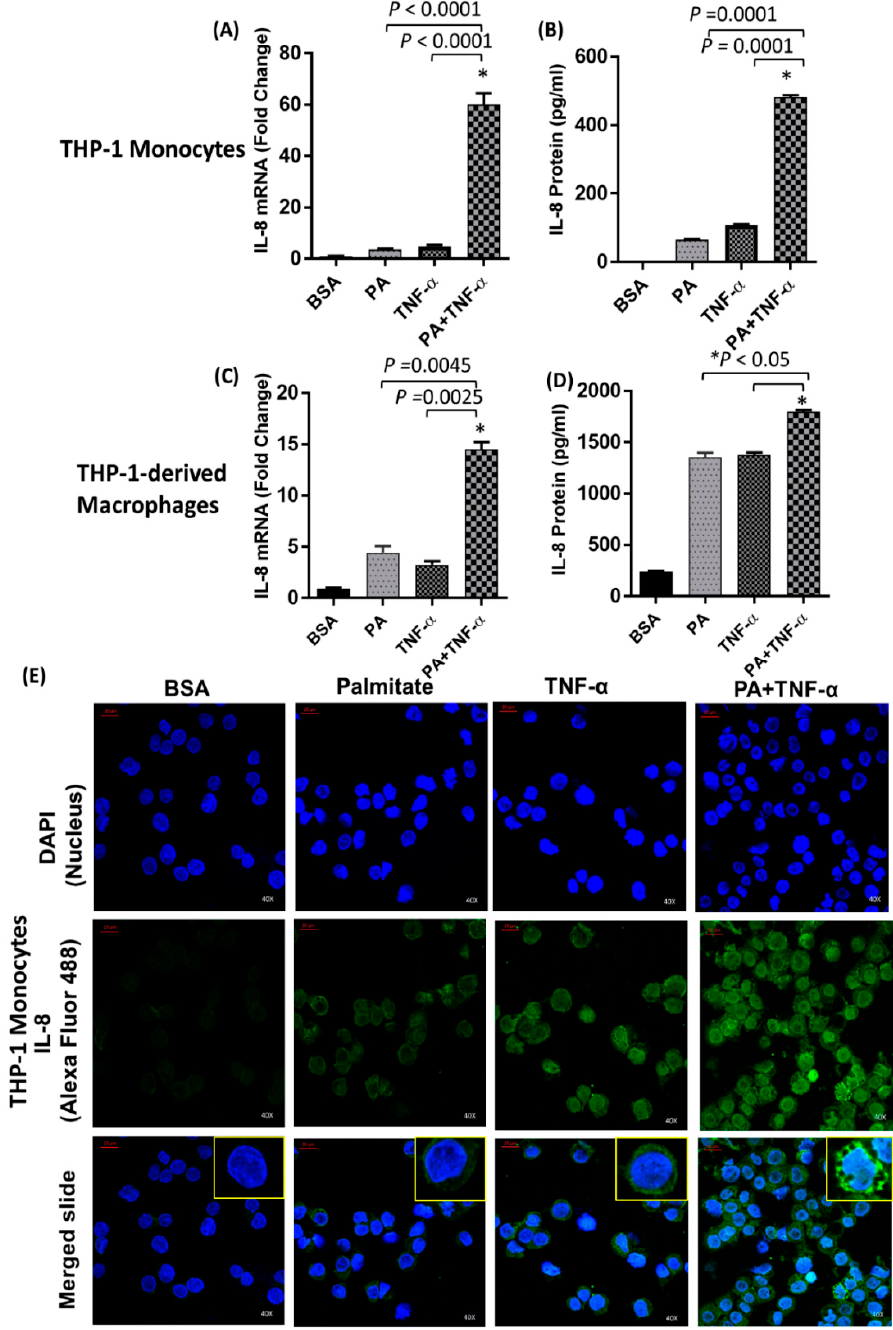
Figure 1. Palmitate and TNF- α synergistically induce IL-8 in THP-1 monocytes. ( A ) THP-1 cells were treated for 24 h with palmitate (PA; 200 µ M) alone or in combination with TNF α (10 ng / mL). Total RNA was extracted, and IL-8 mRNA was quantified by real-time PCR. Relative mRNA expression was expressed as fold change. ( B ) Secreted IL-8 protein in culture media was quantified by ELISA. ( C , D ) THP-1-derived macrophages were treated as described above and IL-8 mRNA expression and protein secretion were determined. The results obtained from three replicates of each experiment are shown. Data are expressed as mean ± SEM. ( E ) THP-1 cells were immune-stained for confocal microscopy as described in the Methods. IL-8 expression is shown by green fluorescence (inset) while nuclei are stained blue with DAPI (40X magnification).